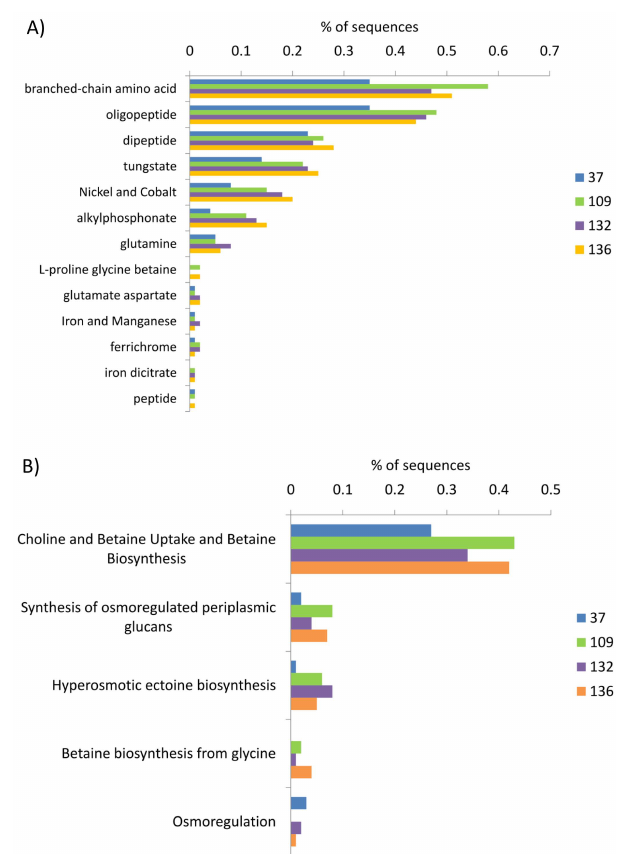
Fig. 3. Breakdown of subsystem contribution to (A) ABC trans- porter and (B) osmotic stress categories. Subsystems are the third level of organization within the MG-RAST